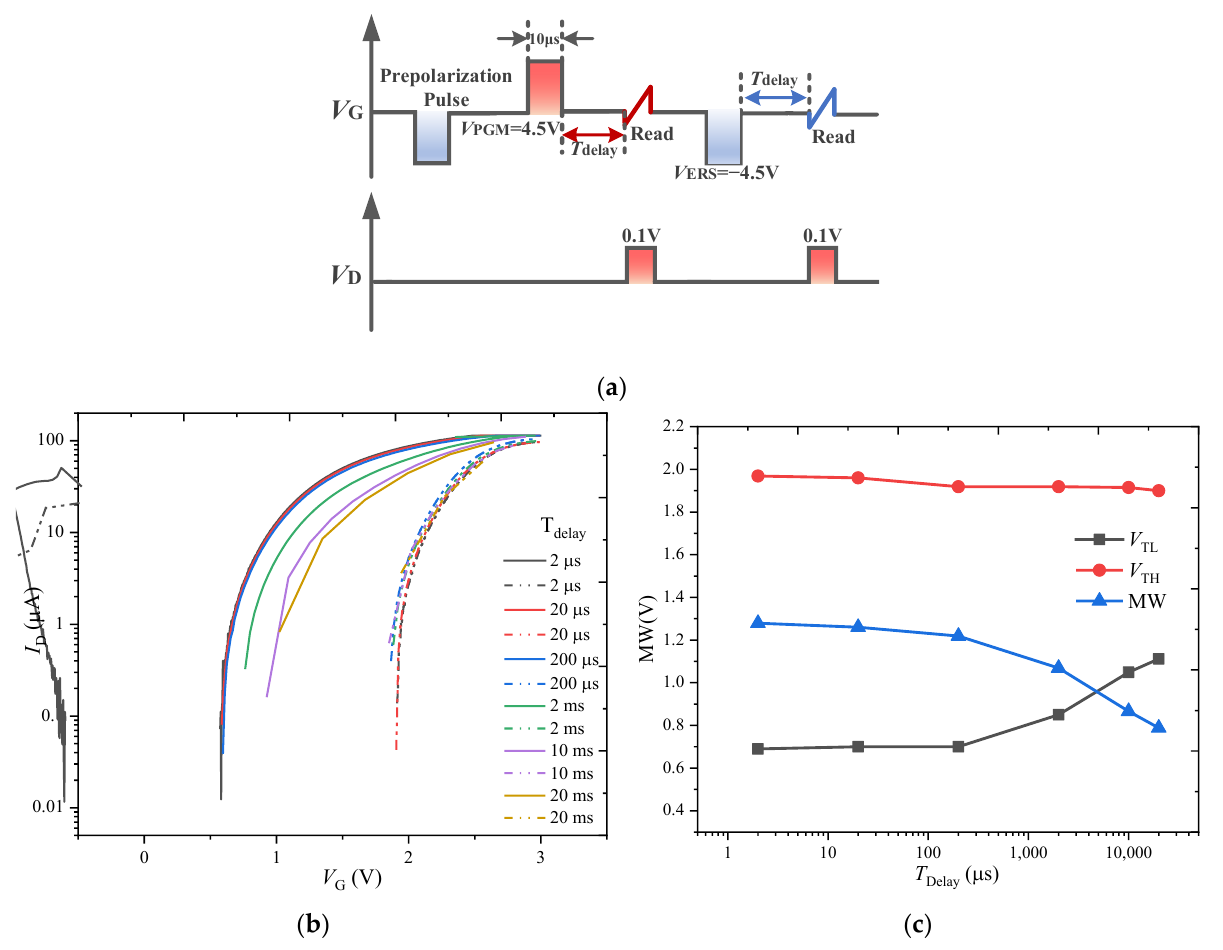
Figure 7. ( a ) Pulse sequence used for MW test at various T delay of the FeFET. ( b ) I D - V G characteristics of FeFET for varying T delay . ( c ) Variation of V TL , V TH , and MW at various values of T delay in FeFET.